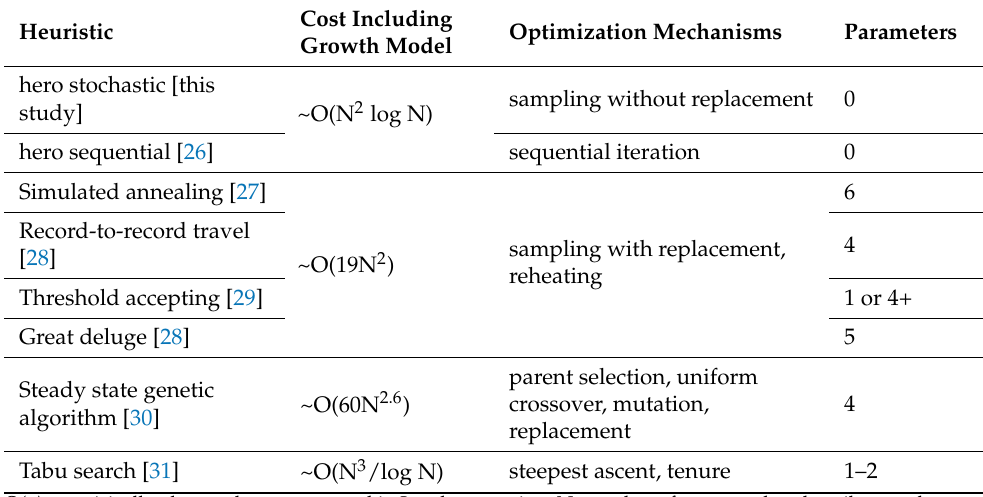
Table 4. Comparison of heuristics evaluated in this study in order of increasing computational cost. Details of heuristic implementations and optimization mechanisms are provided in the Supplemen- tary Material.